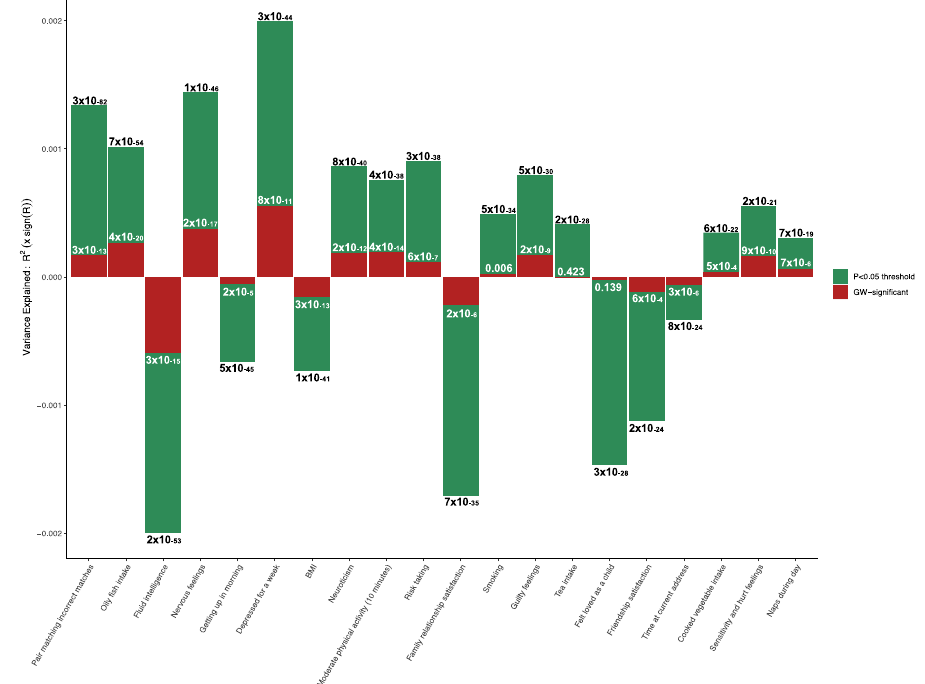
Fig. 1 Bar plot showing 20 of the most signi fi cant associations. y -axis shows target trait variance explained, upwards for positive and downwards for negative associations; with P -values of association shown on bars. The green bars show the best- fi t schizophrenia PRS and the corresponding target traits ( x -axis), and the red bars show the association results when using the genome-wide signi fi cant (GW-signi fi cant) schizophrenia PRS instead (based on the 108 sentinel schizophrenia SNPs). See Supplementary Table 2 for details and to inspect the selection of these 20 results among the top